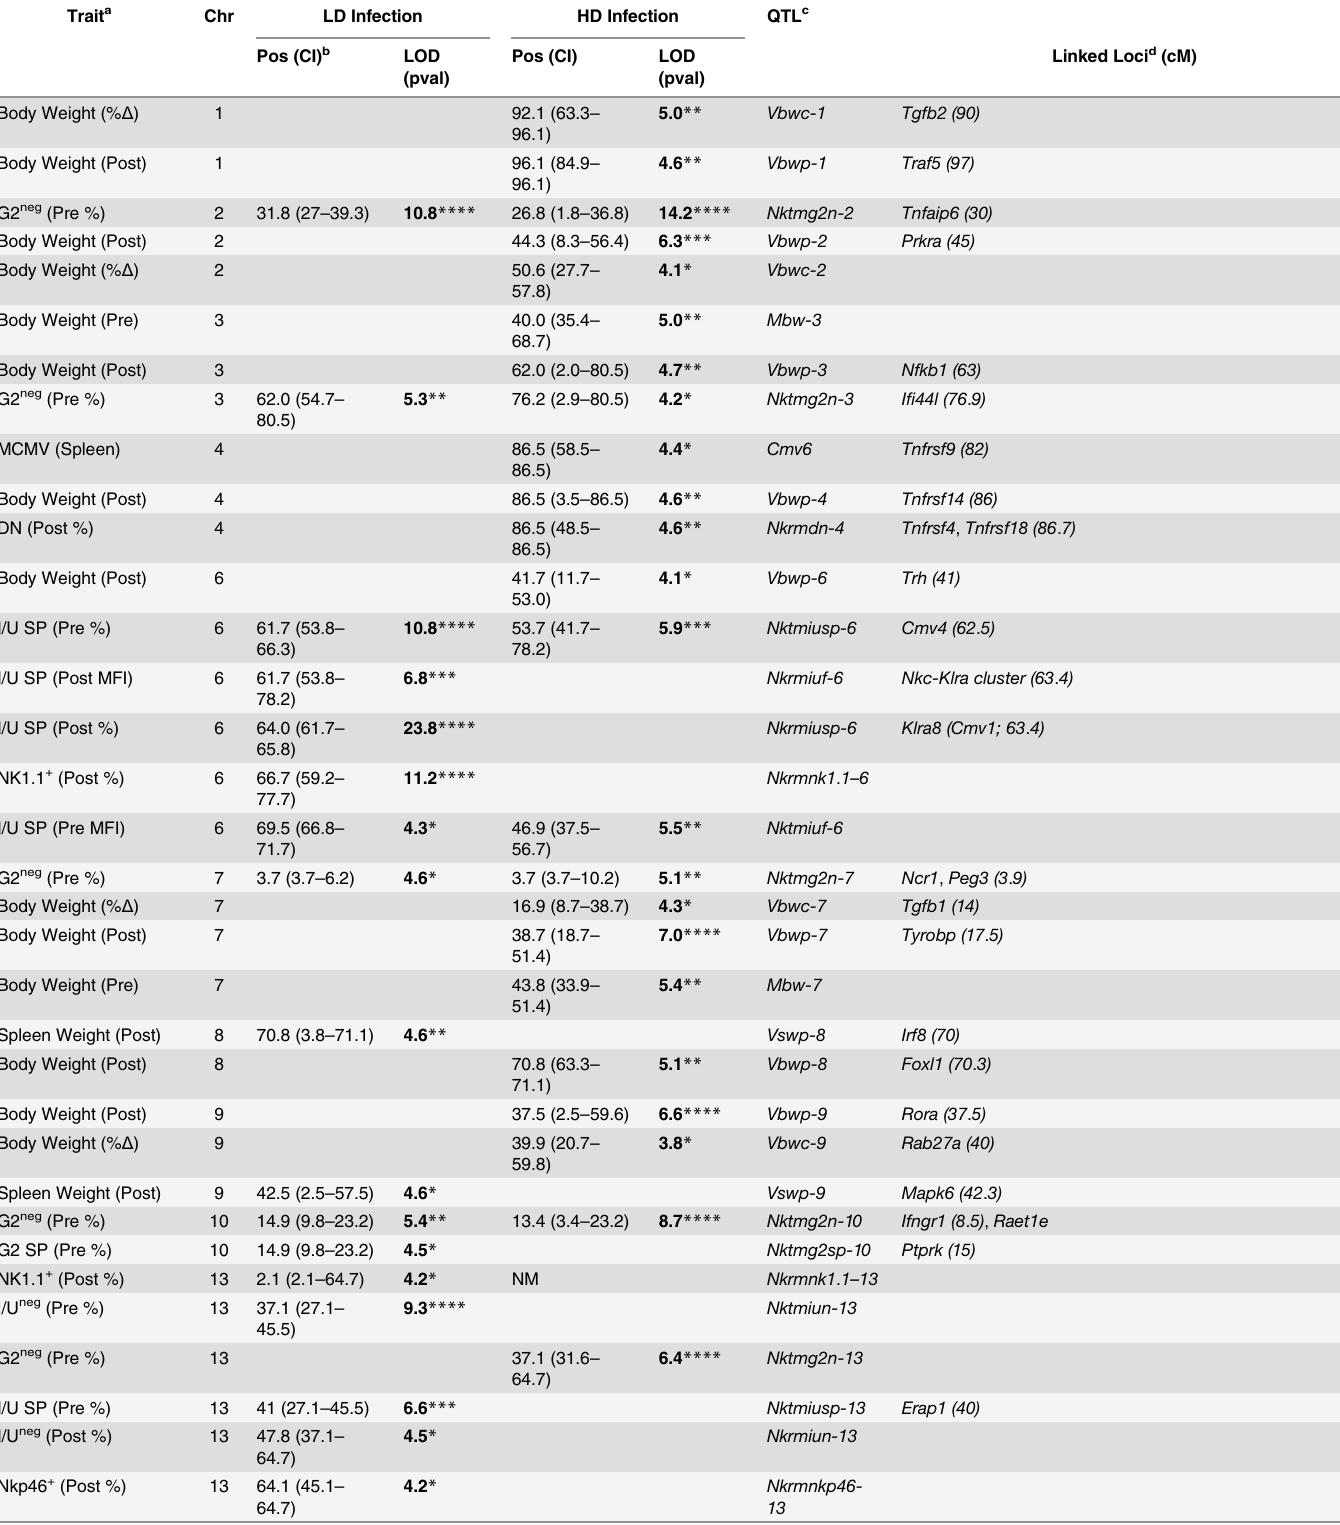
Table 1. Genome-wide scan results for immune and host response